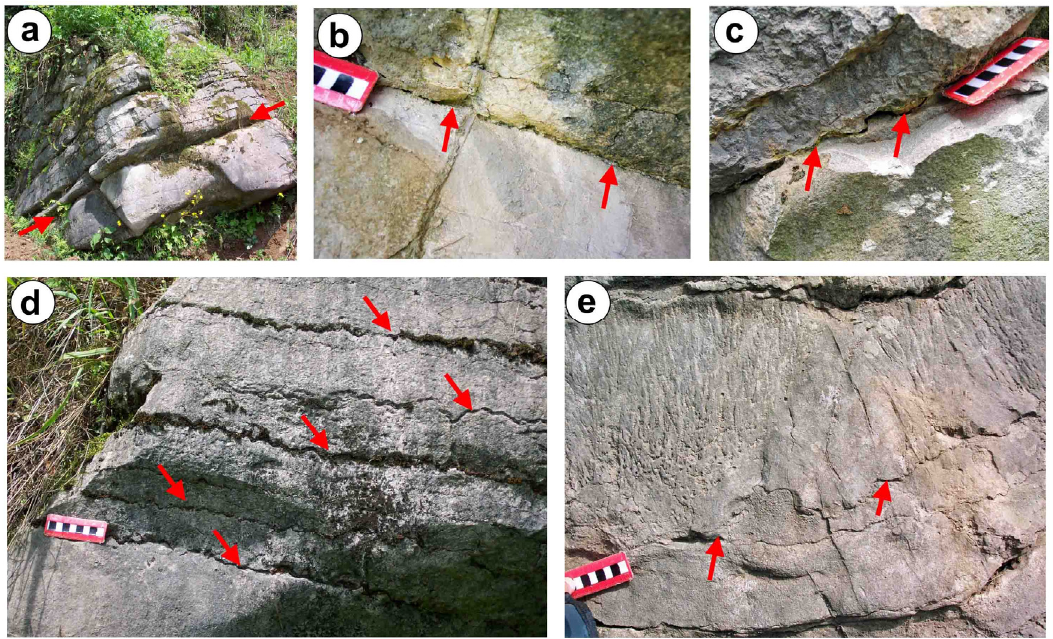
Figure 1. Field photographs of the Permian-Triassic boundary interval in Dongwan locality, Sichuan Province, South China. ( a ) Latest Permian Changhsingian limestones (below red arrows marking the boundary between Changhsingian limestones and the post-extinction microbialite) are conformably overlain by post-extinction microbialites; ( b ) and (c ) Views of the contact between latest Permian limestones and microbialite; the contact represents the latest Permian pre-extinction beds, followed by post-extinction facies. The contact is bed-parallel but is marked by prominent irregular stylolites (red arrows) representing an unknown amount of dissolution of rocks in the critical extinction levels. No researchers have yet described an unstylolitized transition across the extinction boundary in the Sichuan and Chongqing sites; ( d ) Bed contacts in the microbialite are all marked by stylolites (red arrows); ( e ) Prominent stylolite (red arrows) near the top of the microbialite, representing substantial loss of limestone by